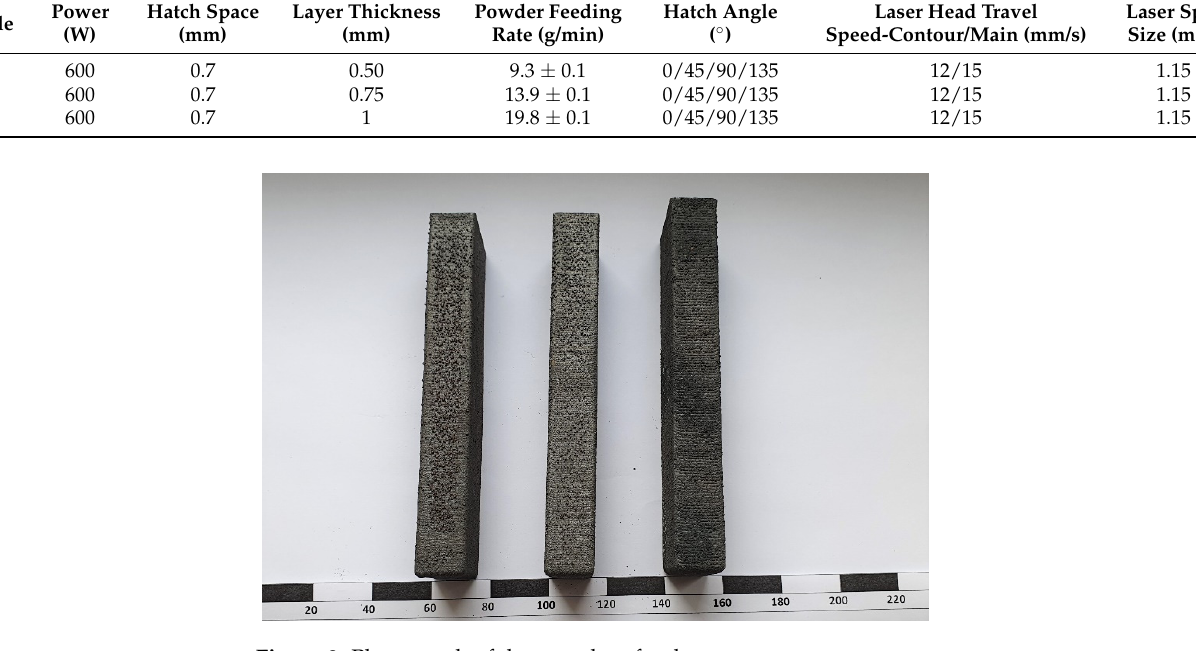
Figure 3. Photograph of the samples after heat treatment.